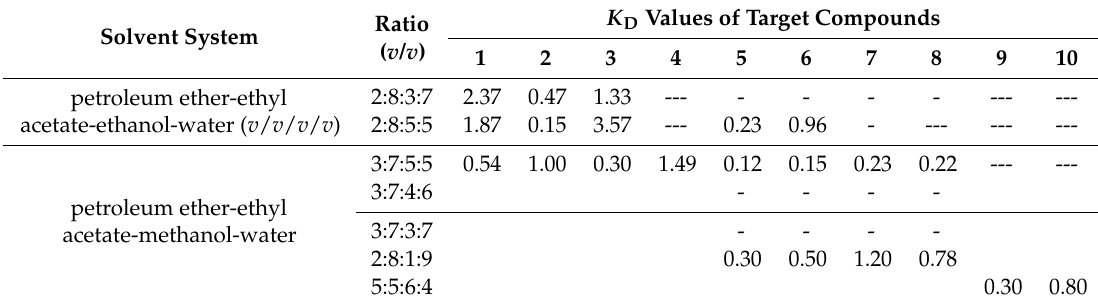
Table 1. Partition coefficients ( K D ) of the target compounds in different solvent systems. Ratio Solvent System petroleum